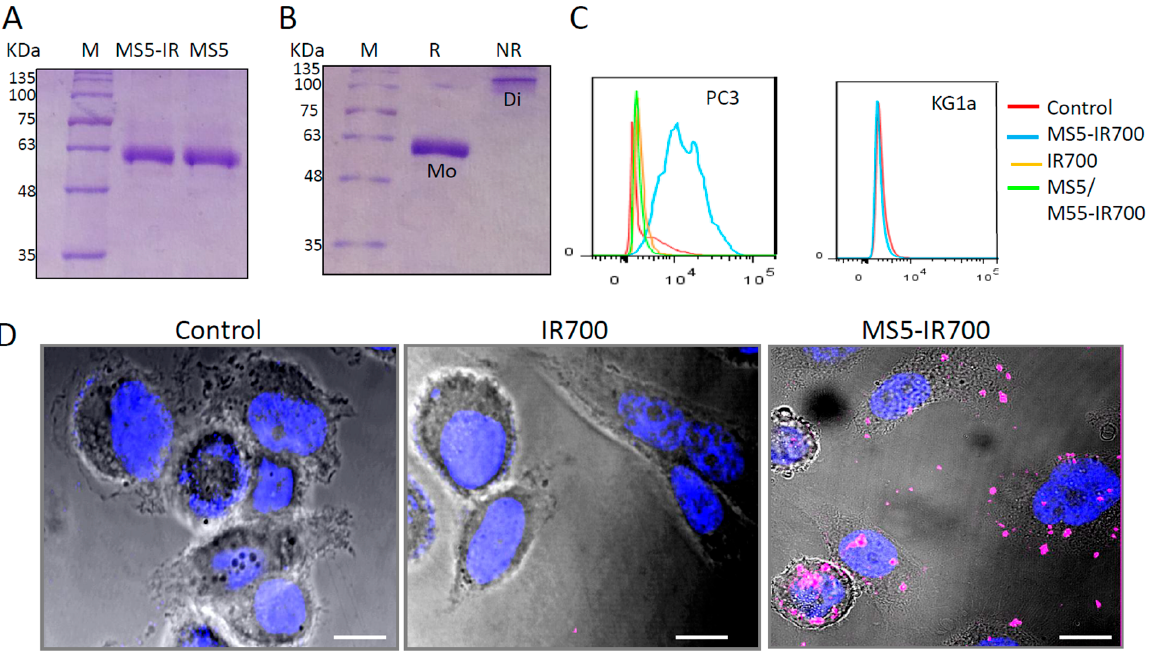
Figure 1. Characterization of the MS5-IR700 conjugate. ( A ) SDS-PAGE analysis of the MS5 minibody and MS5-IR700 conjugate. ( B ) SDS-PAGE analysis of the MS5-IR700 conjugate under reducing (R) and non-reducing (NR) conditions. Mo = monomers, Di = dimers, M = Markers. ( C ) Binding of the MS5-IR700 conjugate to PC3 prostate and KG1a cancer cell lines. The cells were stained with the conjugate (5 µ g/mL) and then analyzed by flow cytometry. ( D ) Representative confocal images presenting PC3 cells stained with IR700 or MS5-IR700 conjugate (pink) following one-hour incubation at 37 ◦ C. Nuclei were visualized with Hoechst 33342 staining (blue). Phase-contrast and fluorescence images were taken using a Zeiss LSM880 AiryScan confocal microscope. Scale bars present 20 µ